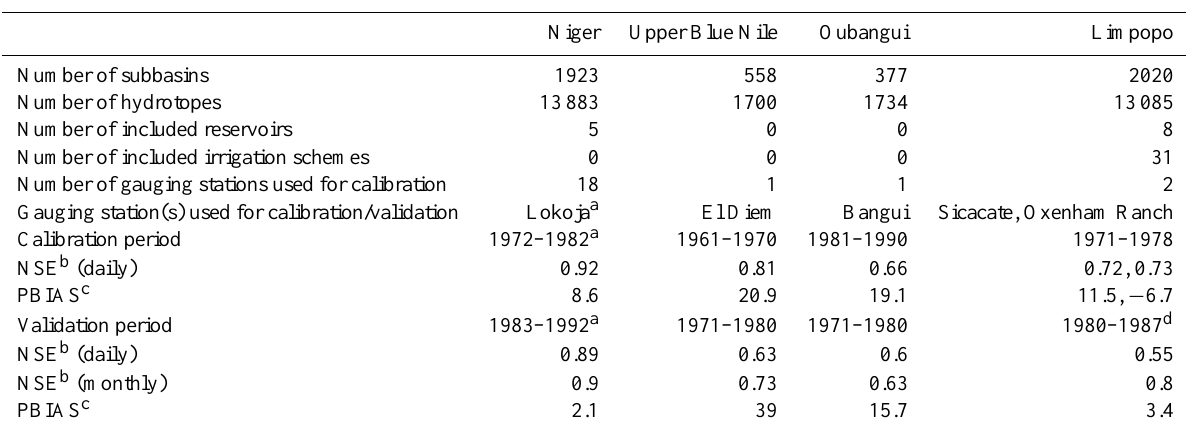
Table 3. Characteristics of basin models and validation